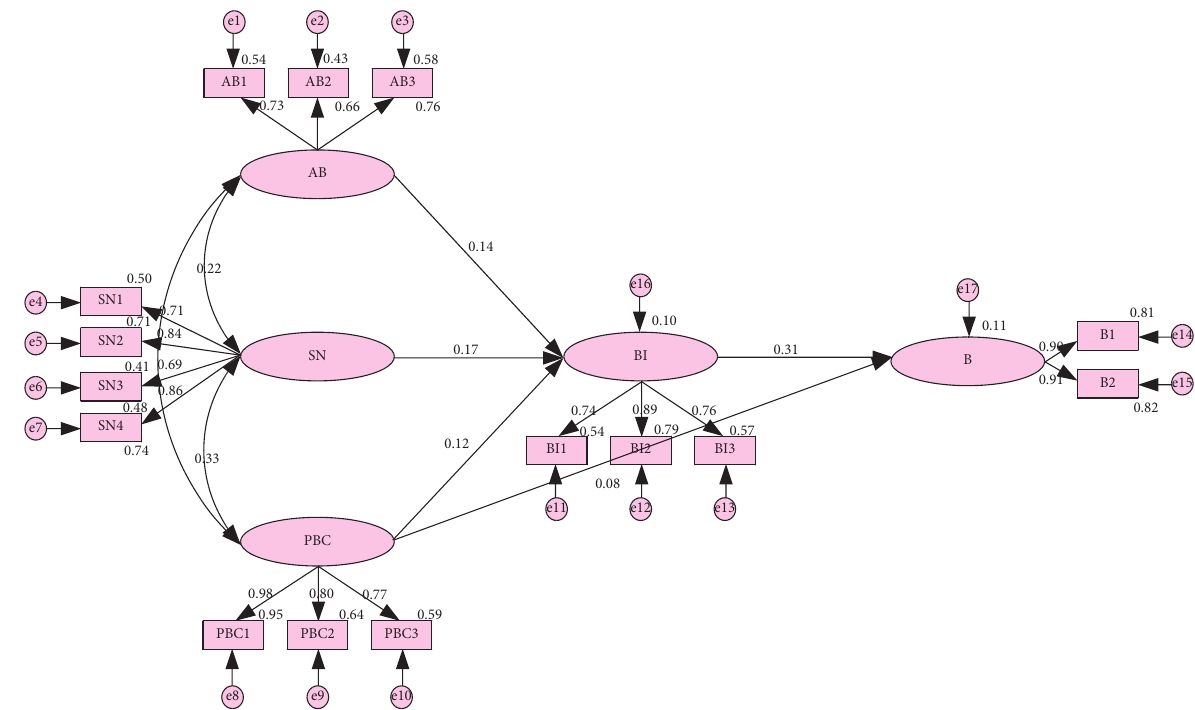
Figure 2: Structural equation model of road-crossing violation behaviors among young pedestrians. Table 10: Fit indices for the structural equation